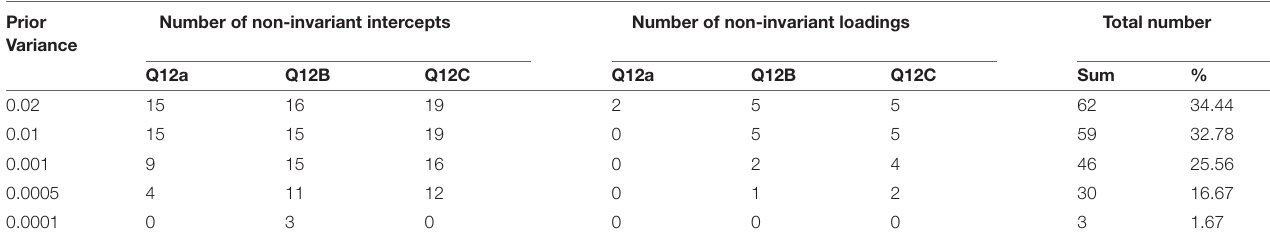
TABLE 7 | The number of non-invariant parameters for the BAMI models with alignment. Prior Number of non-invariant intercepts Number of non-invariant Variance